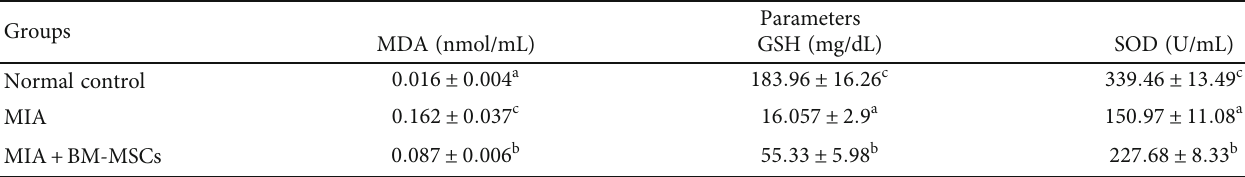
Table 4: E ff ect of BM-MSCs on serum levels of MDA, GSH, and the activity of SOD of MIA-induced OA. Groups